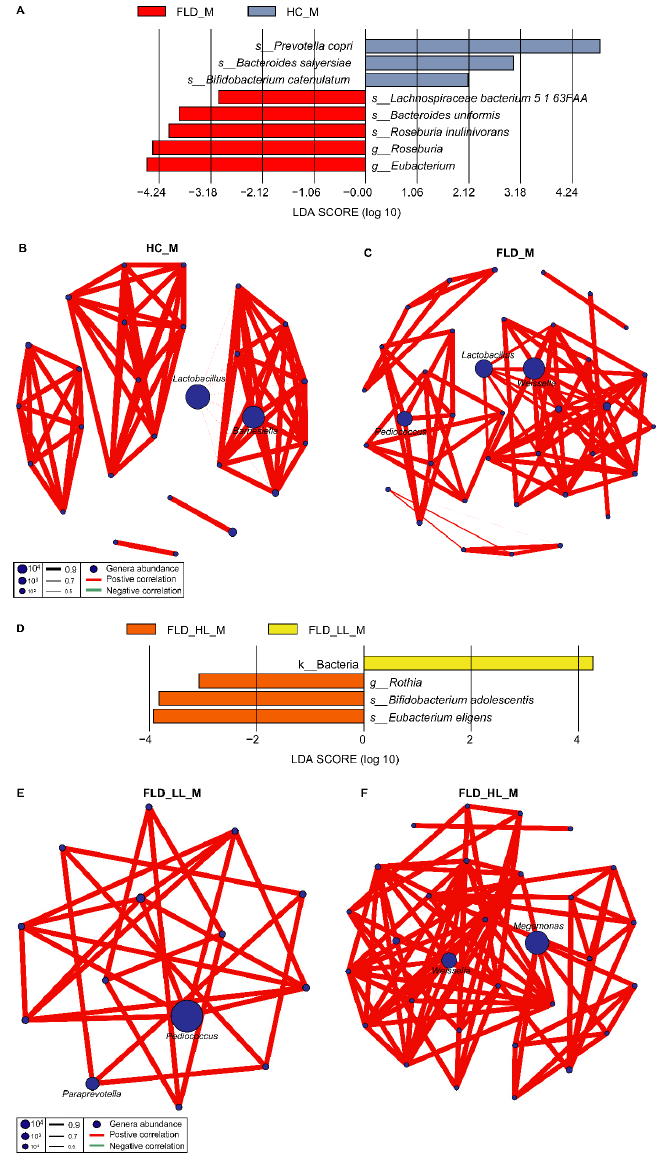
Figure 4. ( A ) The microbial biomarkers in groups HC_M and FLD_M include Prevotella copri , Bac- teroides salyersiae , Bifidobacterium catenulatum , Eubacterium , Roseburia , Lachnospiraceae bacterium 5 1 63FAA , Bacteroides uniformis , and Roseburia inulinivorans . ( B , C ) Microbiome network of groups HC_M and FLD_M. ( D ) LEfSe analysis revealed that Rothia , Eubacterium eligens , and Bifidobacterium adolescentis were enriched in group FLD_HL_M. ( E , F ) Microbiome network of groups FLD_LL_M and FLD_HL_M.